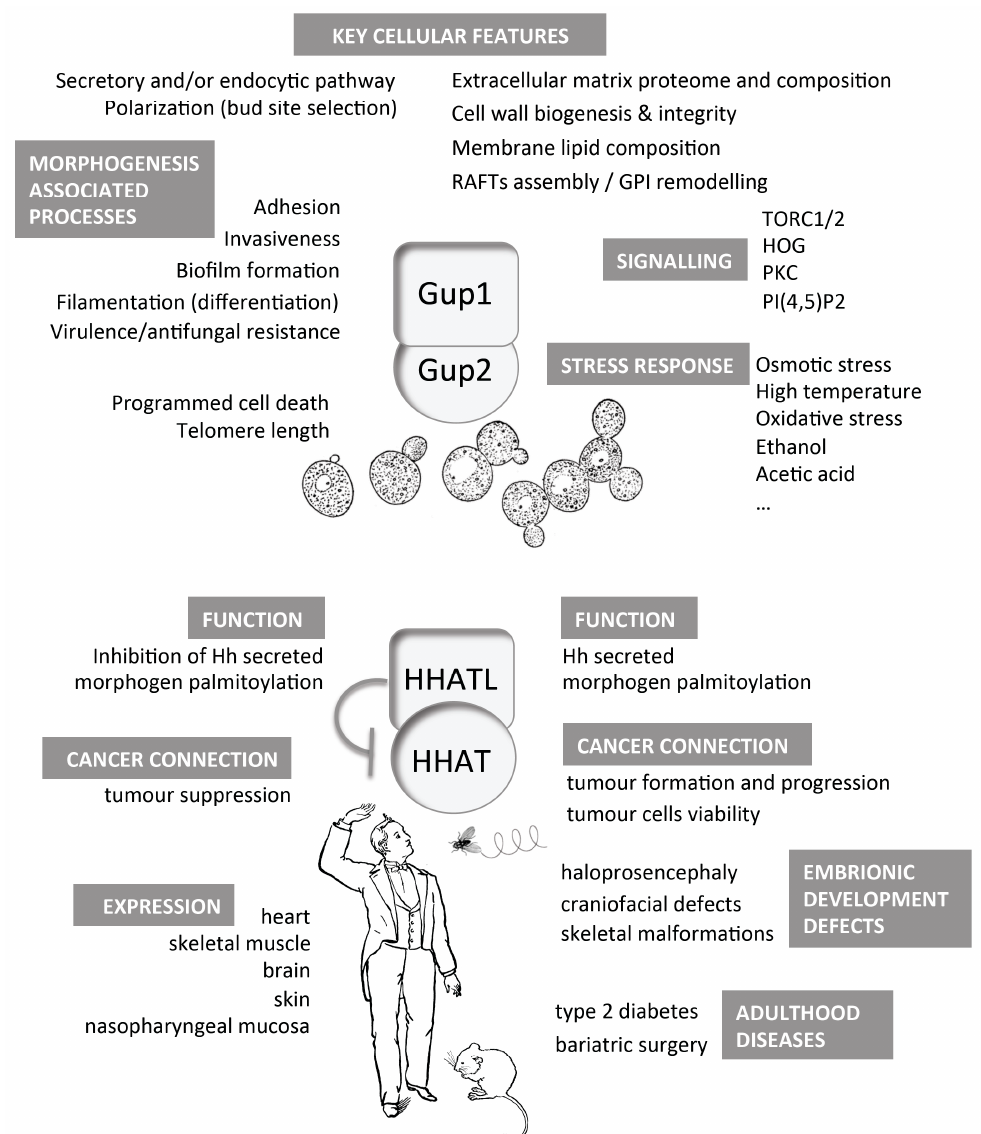
Figure 6. Phenotypes and biological processes associated to the Gup proteins in yeasts ( S. cerevisiae and C. albicans ) and in the higher eukaryotes M. musculus , H. sapiens and D. melanogaster . Clipart was